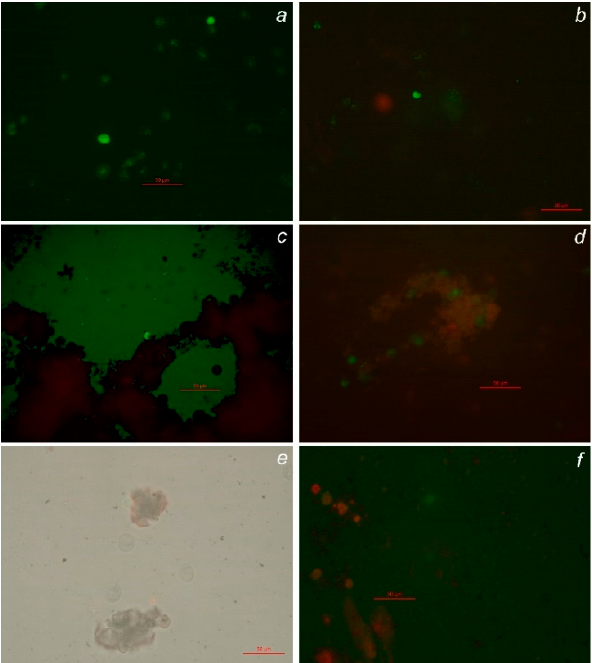
Figure A3. Thehemocytecellsofthemollusc A.boucardi after6hofexposurewiththeNPsattheconcentration Figure A3. The hemocyte cells of the mollusc A.boucardi after 6 h of exposure with the NPs at the concentration of 1000 mg/L: (a) control; (b) CNT-2; (c) CdS; (d) ZnS; (e) of 1000 mg / L: ( a ) control; ( b ) CNT-2; ( c ) CdS; ( d ) ZnS; ( e ) Au-NPs; and ( f ) TiO 2 Au-NPs; and (f) TiO 2 .